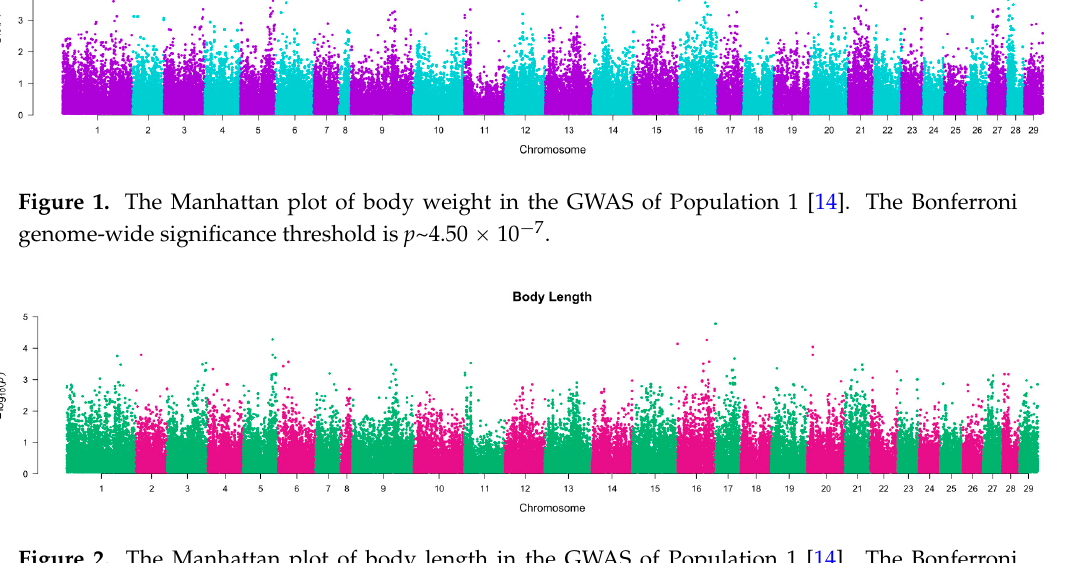
Figure 2. The Manhattan plot of body length in the GWAS of Population 1 [14]. The Bonferroni genome-wide significance threshold is p ~4.50 × 10 -7 .